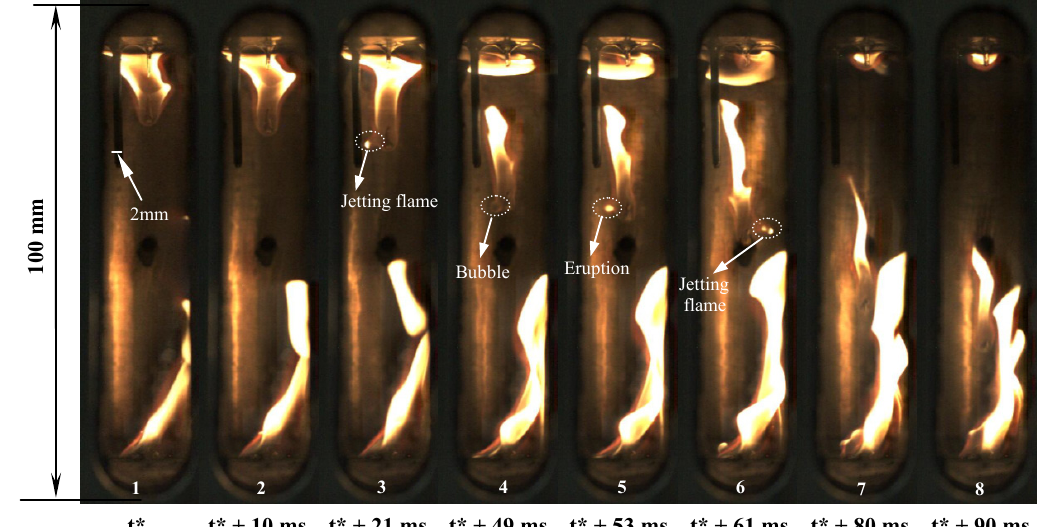
Figure 2. Picture series of falling and burning gelled propellant